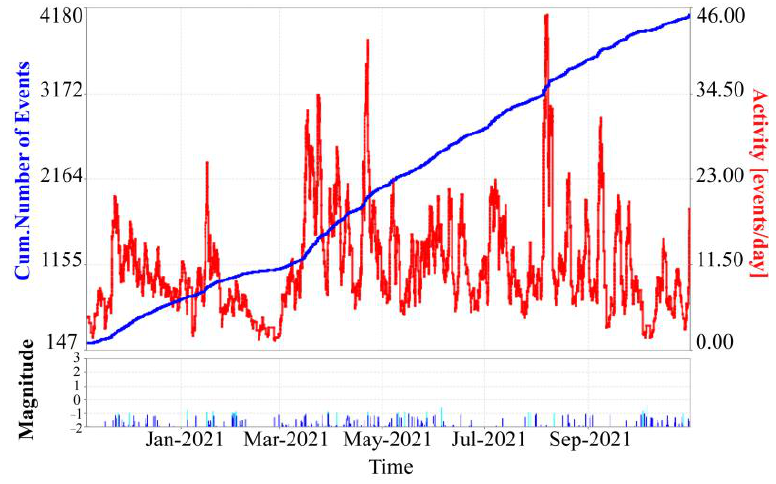
Figure 5. Distribution of microseismic event accumulation and activity time.